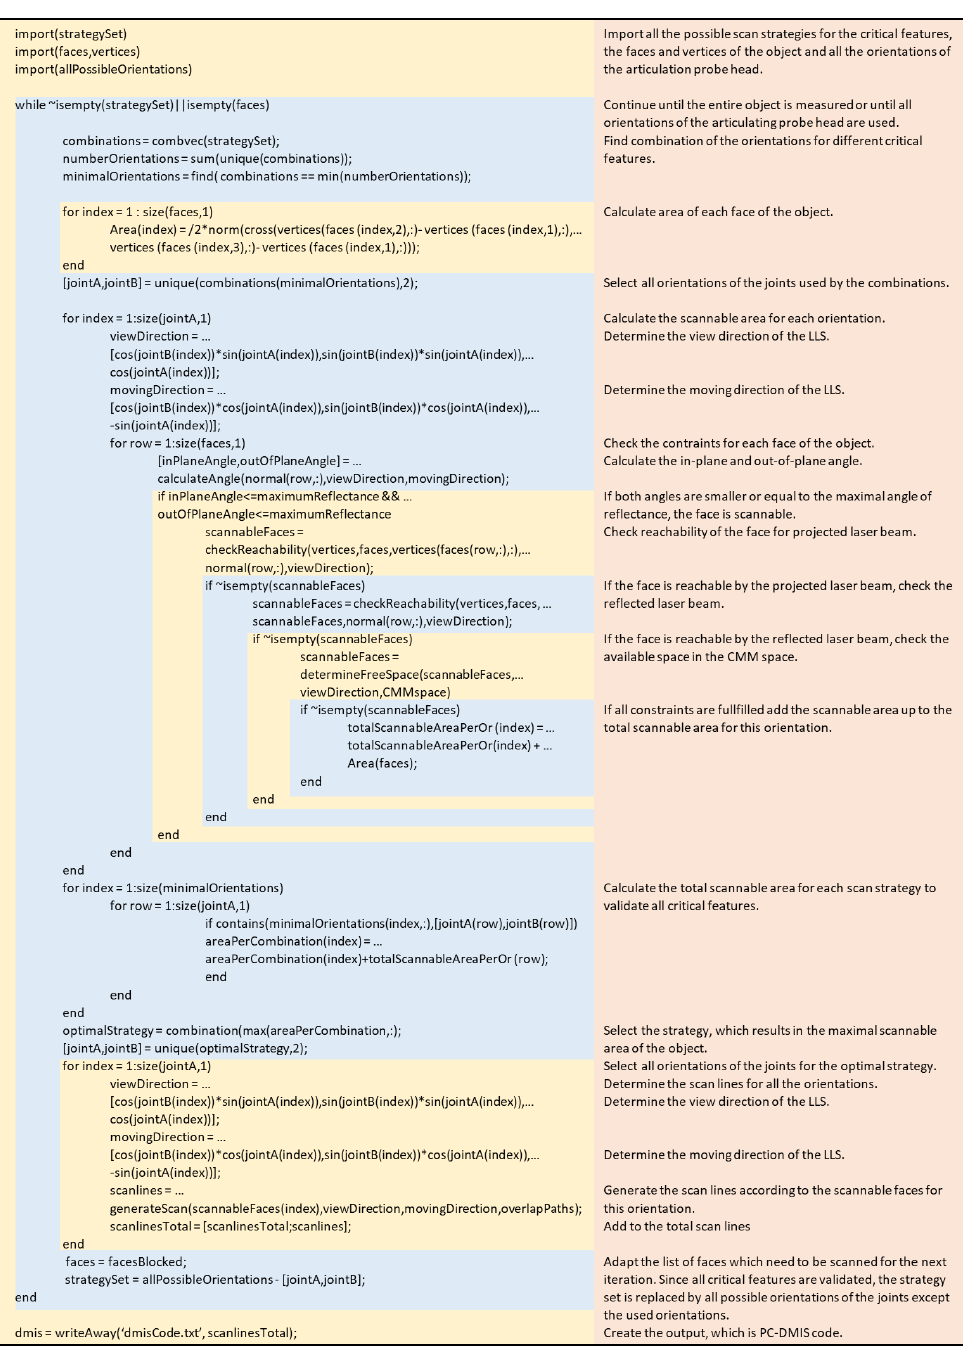
Figure A1. The pseudo-MatLab code for the autonomous scan path generation.